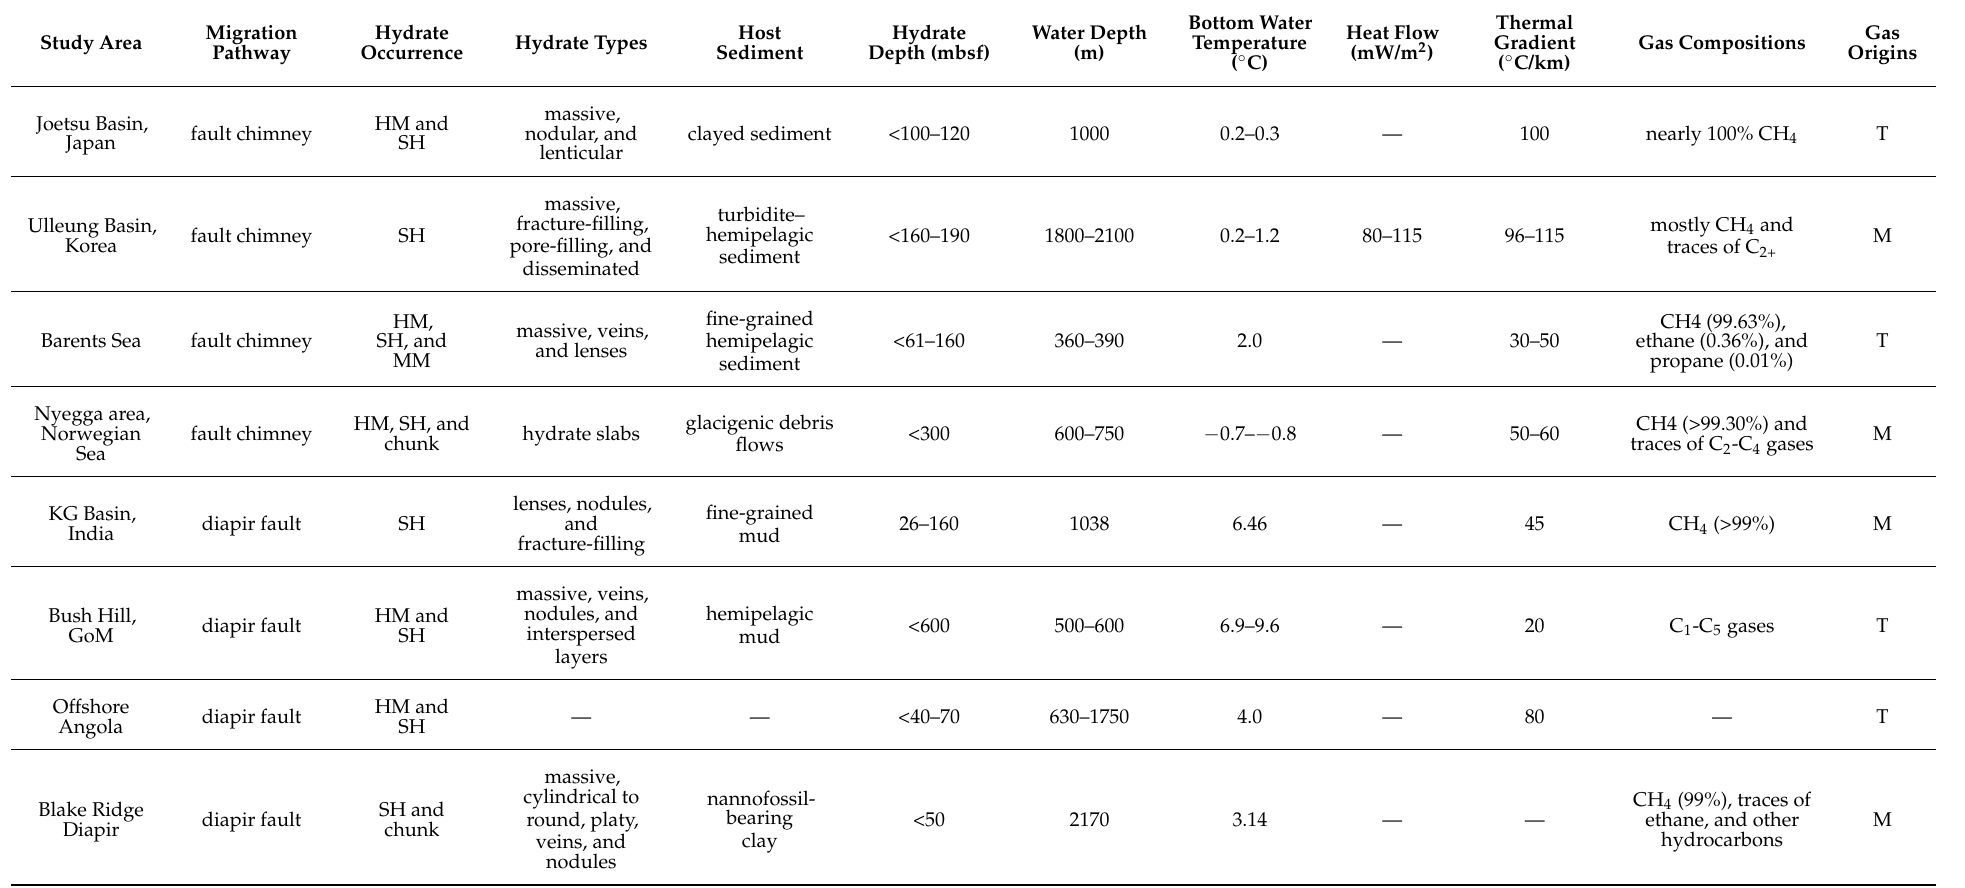
Table 1. Elements of gas hydrate systems described in this